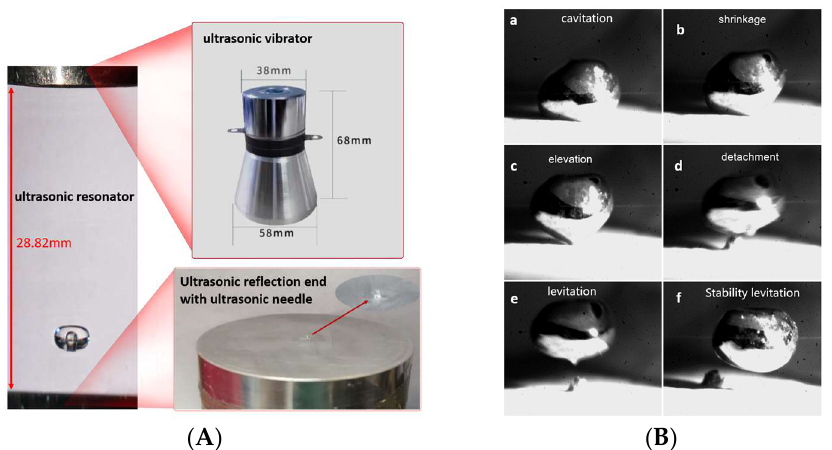
Figure 13. The experimental process of Ga-In droplet. ( A ) Ultrasonic composite fields experimental environment. ( B ) cavitation-levitation process of Ga-In alloy.